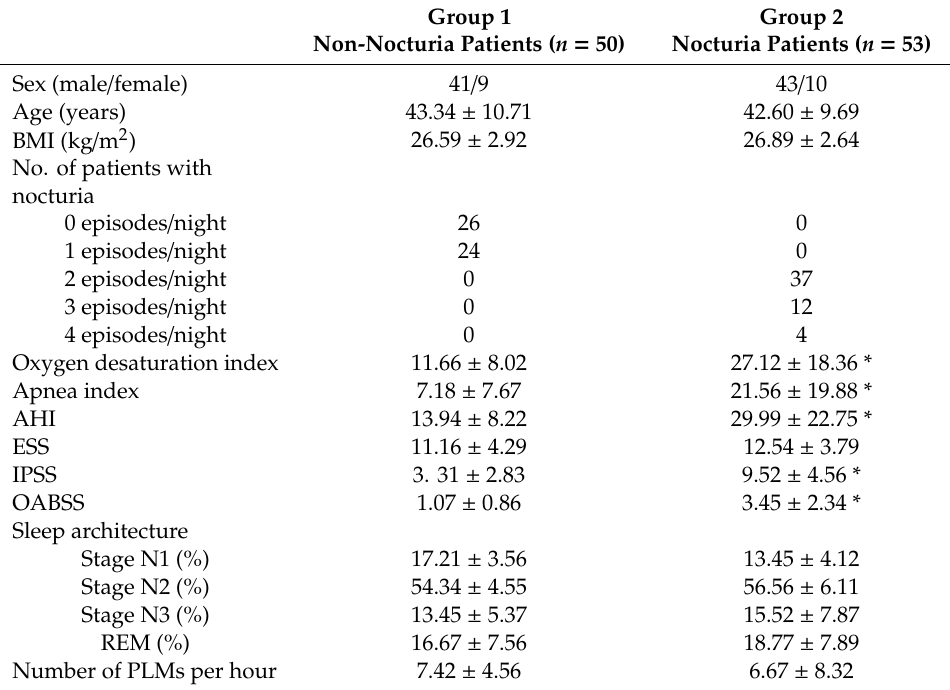
Table 1. The characteristics of the 103 obstructive sleep apnea (OSA)-diagnosed patients. Group 1 Group 2 Non-Nocturia Patients ( n = 50)